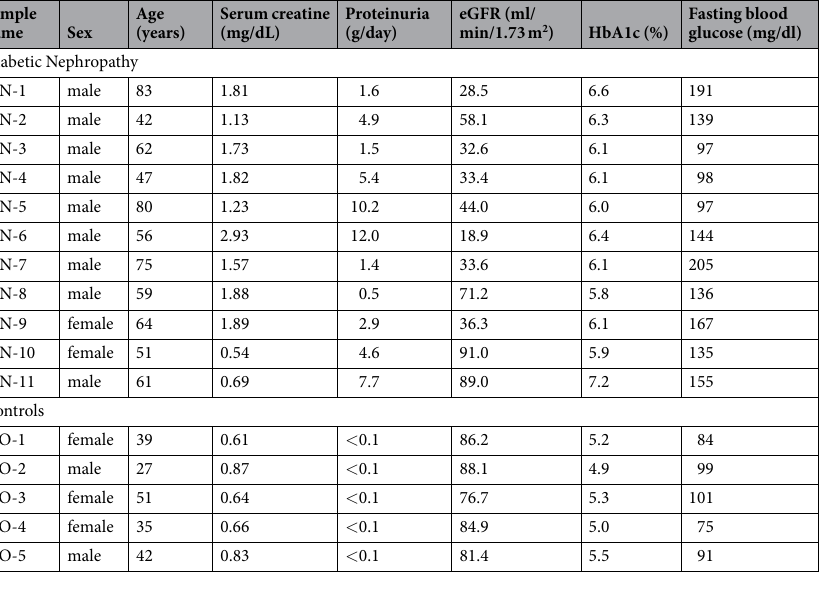
Table 1. Clinical parameters of patients with diabetic nephropathy (DN) and controls at the time of renal needle